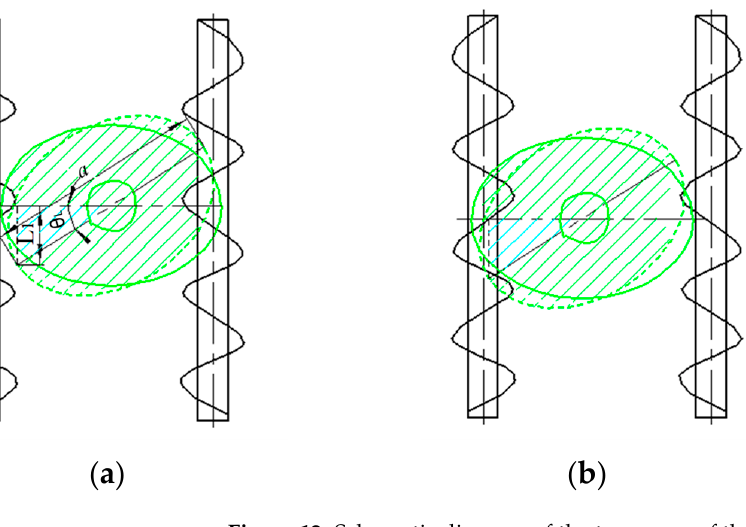
Figure 12. Schematic diagram of the two cases of the block falling onto the double spiral adjusting mechanism: ( a ) block biased to the right of the spiral rod; ( b ) block biased to the left of the spiral rod; ( c ) the direction of the longest dimension of the block has a large taper angle or is even perpendic- ular to the axis of the spiral rod